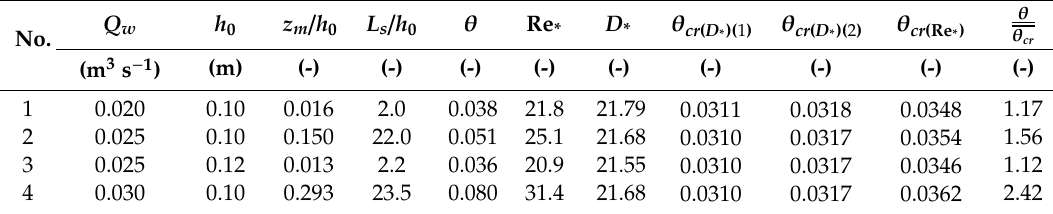
Table A1. Summary table of calculation results—variant I of flume development; no water structure; “clear-water”